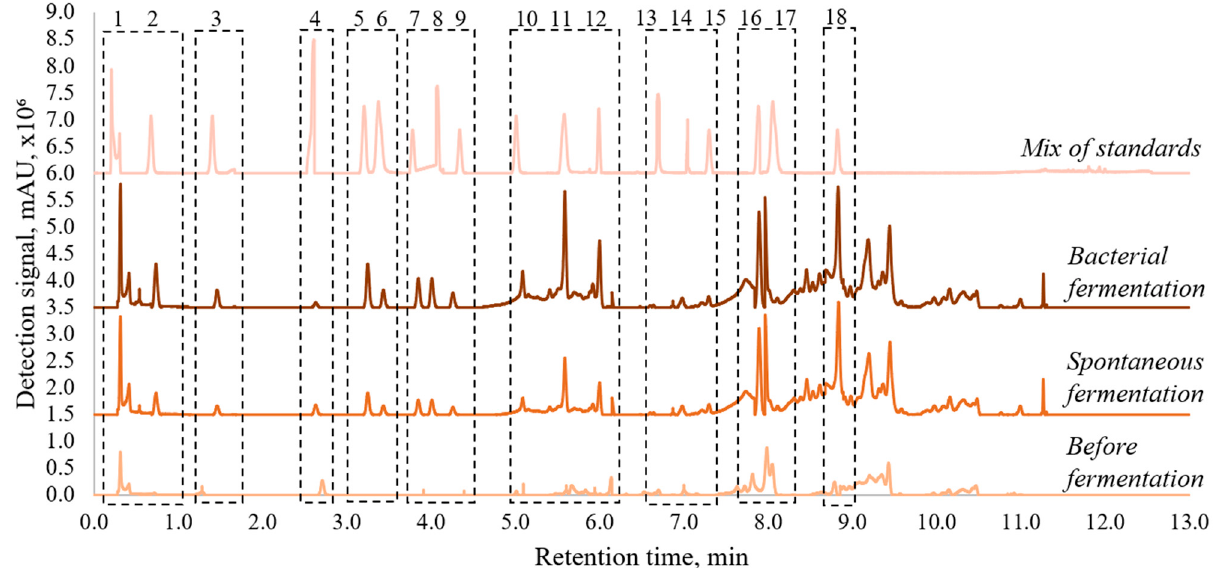
Figure 1 . Chromatographic profiles of Lithuanian pollen sample (1—lactic acid, 2—gallic acid, 3— benzoic acid, 4—chlorogenic acid, 5—vanillic acid, 6—caffeic acid, 7—syringic acid, 8—salicylic